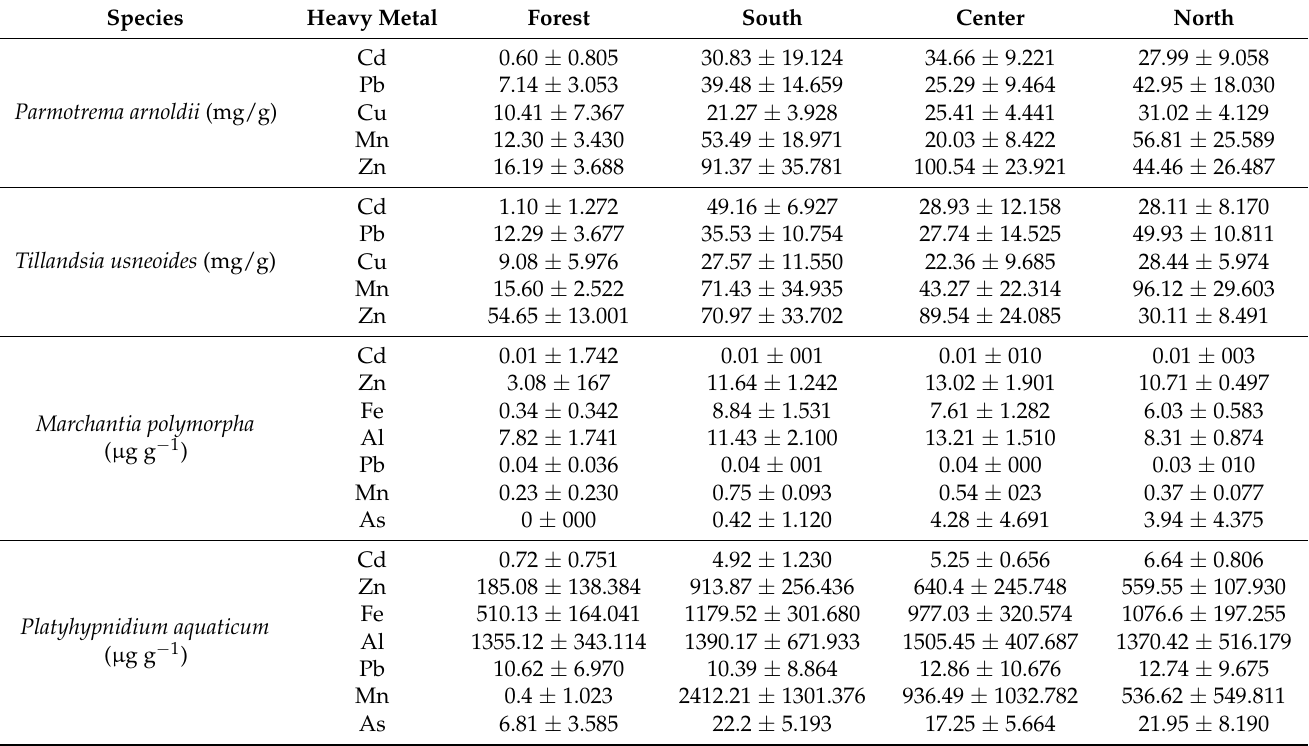
Table 1. Descriptive statistics on heavy metals (mg/g) in Parmotrema arnoldii and Tillandsia usneoides . Descriptive statistics on heavy metals ( µ g g − 1 ) in Marchantia polymorpha and Platyhypnidium aquaticum . M: mean value; SD: standard deviation.